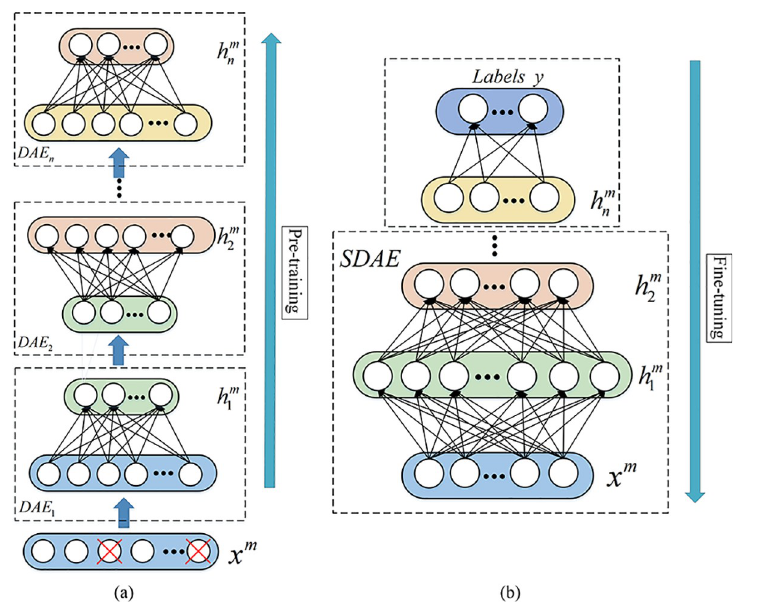
Fig 2. The structure principle of SDAE. (a) Pre-training, (b) Fine-tuning.